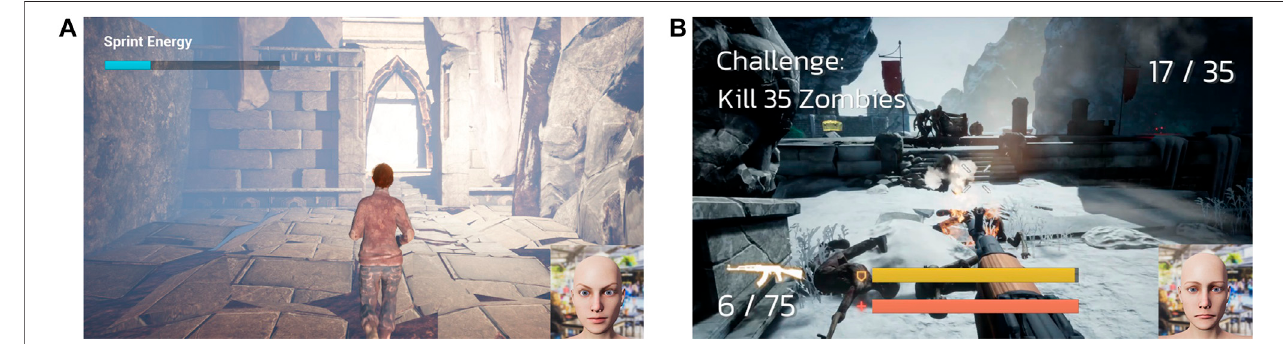
FIGURE 4 | Left: Player sprinting in Temple Looter with facial expression input shown in the inset [the inset face image from (Cuculo et al., 2019)]. Right: Player shooting zombies in the FPS game using a facial expression shown as inset [the inset face image from (Cuculo et al., 2019)].